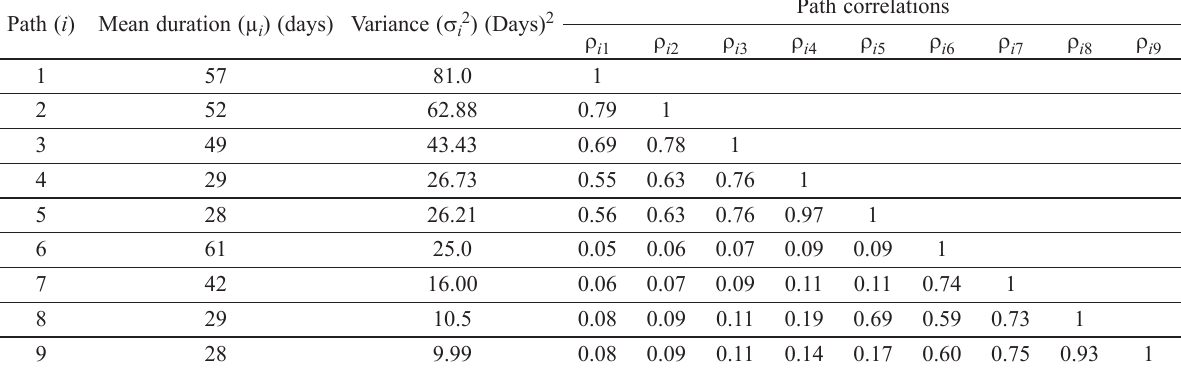
Table 4. Ordered paths and duration statistics